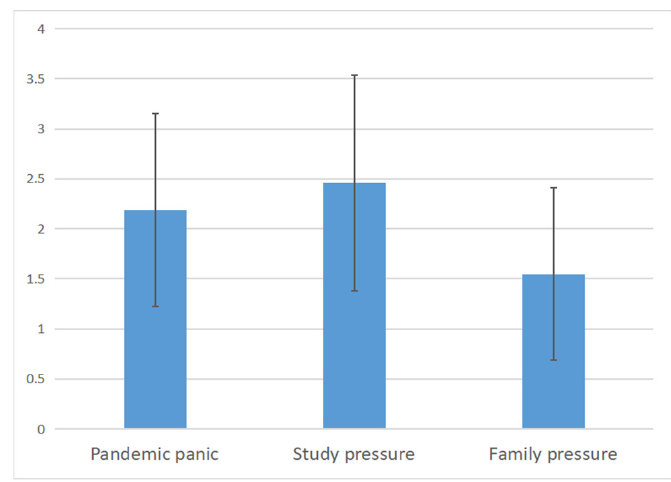
Figure 2. Adolescents’ Pandemic stress perception.